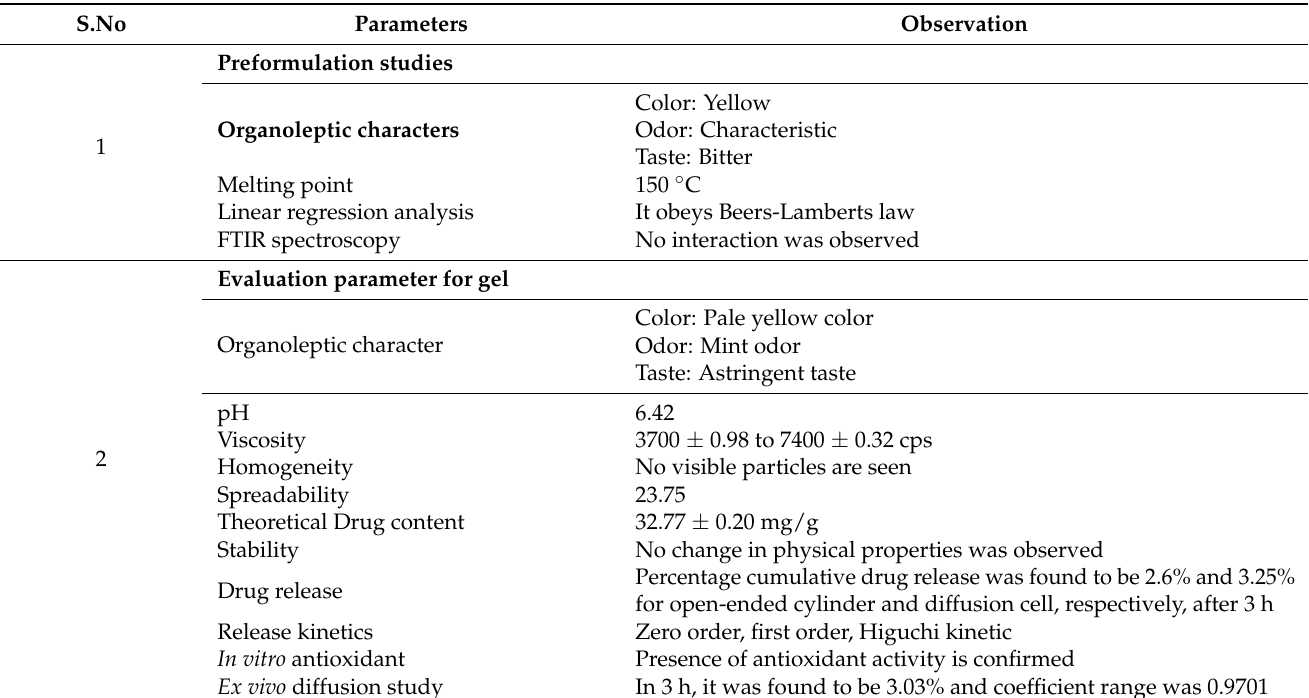
Table 1. Various parameters evaluated in the chosen silymarin gel formulation (F10).